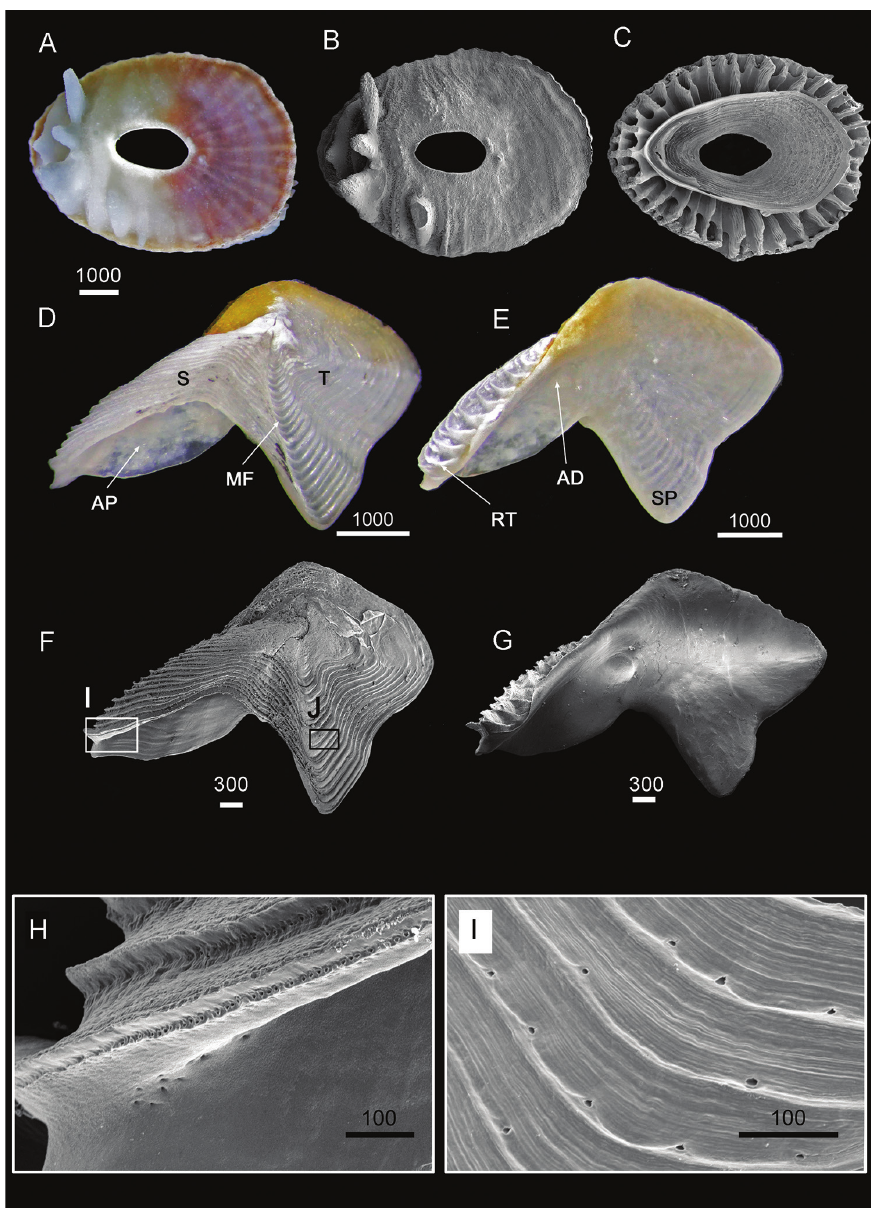
Figure 3. Shell and opercular plates of Galkinius maculosus sp. n. A (LM) and B (SEM) of dorsal view of fused shell (Holotype, ASIZCR000343) C Ventral view of shell (SEM) with internal rids radiating from rim of inner operculum (CEL-LAN-075-09) D Dorsal view and E Ventral view of fused scutum and tergum (ASIZCR000343) F Dorsal view (CEL-DSA-012-9) and G Ventral view (CEL-DSA-012-9) of fused scutum and tergum under Scanning Electron microscope H Horizontal striations on external surface of scutum I Hor- izontal striations on external surface of tergum. Scale bars in μm. Abbreviations: AP: adductor plate, S: scutum, T: tergum, MF: medial spur furrow, RT: rostral tooth, AD: adductor muscle scar, SP: